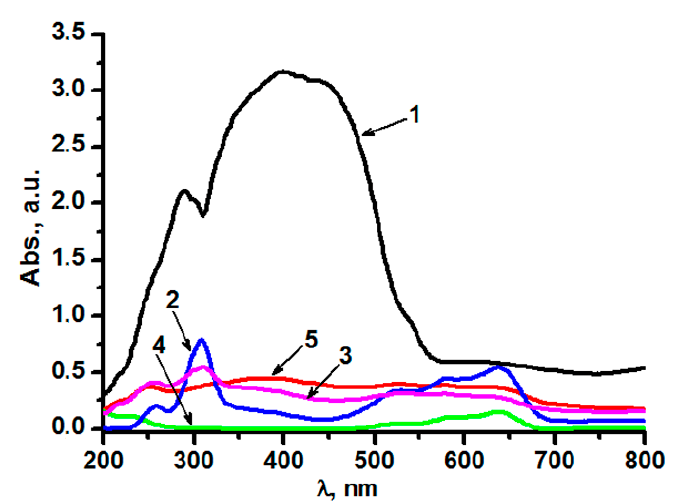
Figure 4. UV–Vis diffuse reflectance spectra of: Co II (bpy) 3 (1); and Co II @SiO 2 synthesized by different techniques: Stöber with Co II (bpy) 3 (2) and CoCl 2 (4); w/o with Co II (bpy) 3 (3) and CoCl 2 (5).